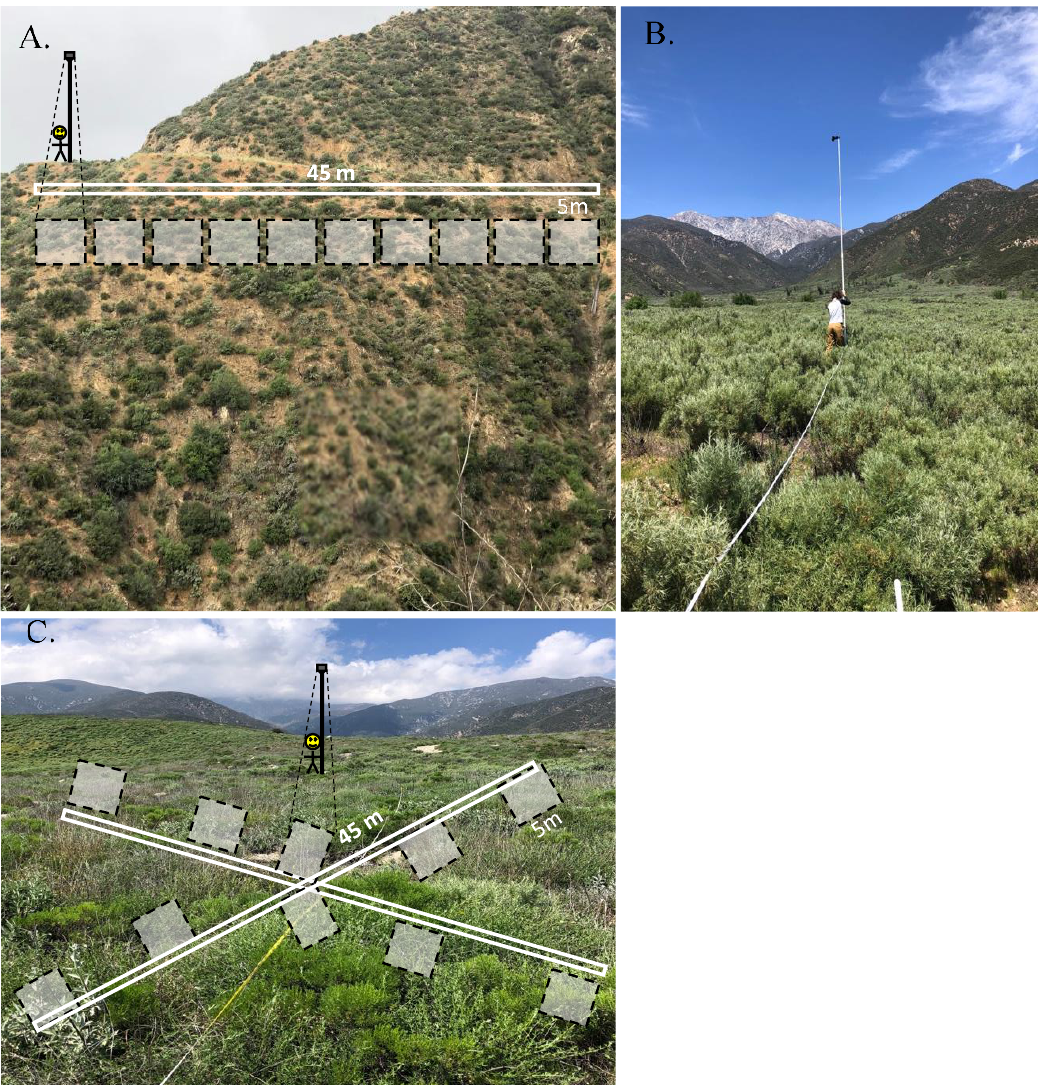
Figure 2. Diagram of photo-survey method for ( A ) steep plots: surveyor walks along a 45-m transect taking 10 5-m × 5-m photos (grey boxes) of the plot below, ( B ) a field crew member taking photos with camera attached to a pole extended 5 m, and ( C ) diagram of photo survey for flat plots: surveyor walks along two crossed 45-m transects taking 10 5-m × 5-m photos from